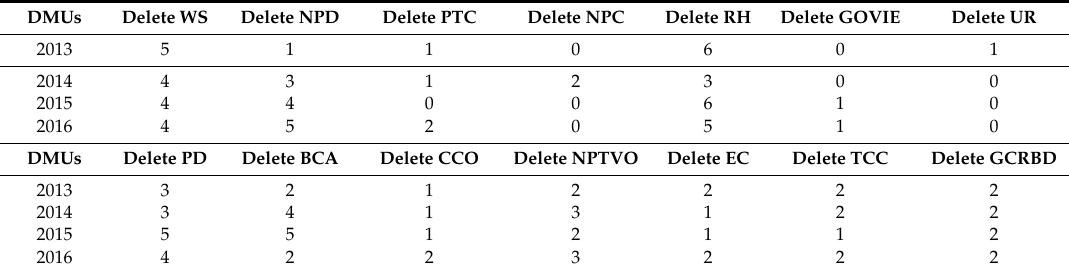
Table 3. The number of cities which stochastic efficiency values changed by deleting single input variable in diffident risk levels from 2013 to 2016.